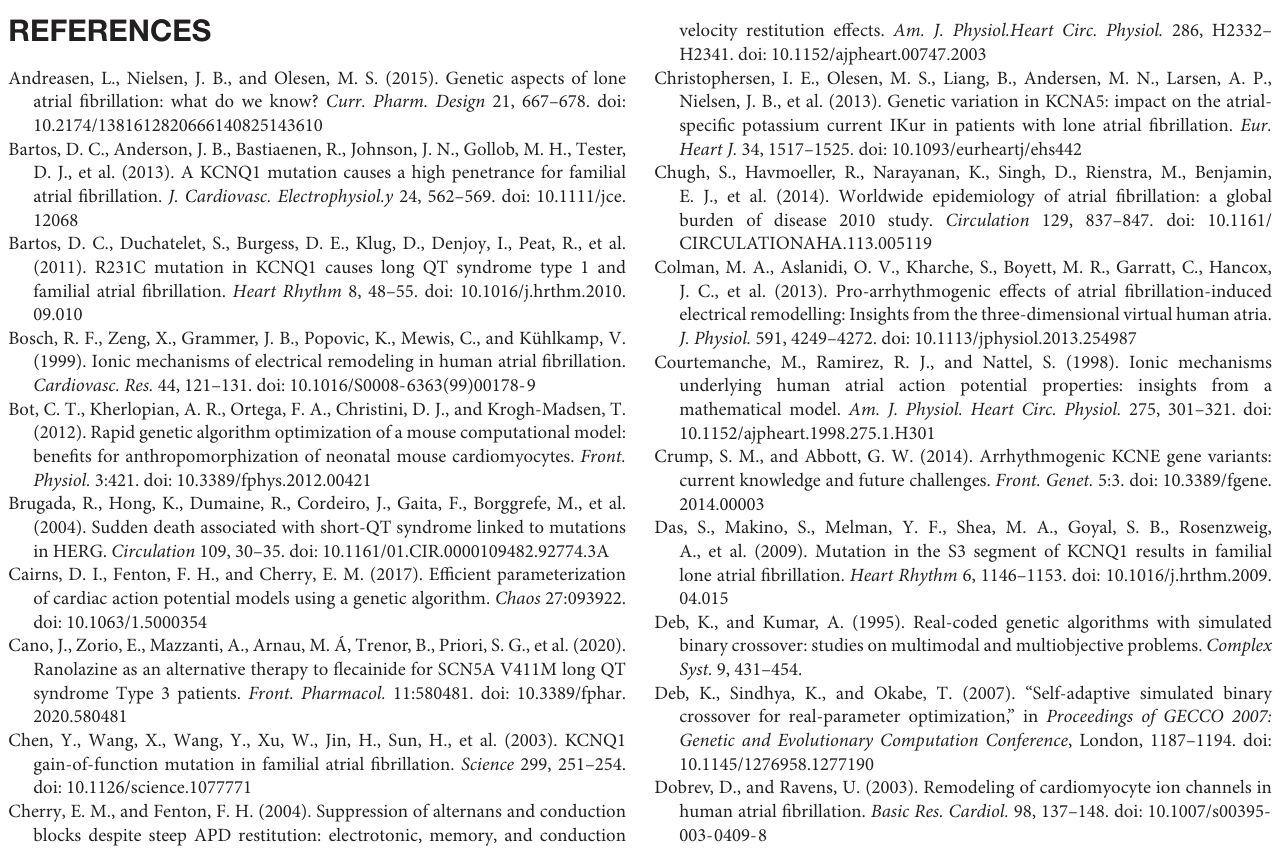
Supplementary Figure 1 | Sensitivity analysis for KCNH2 T436M and KCNH2 T895M I Kr current formulation. Supplementary Figure 2 | Sensitivity analysis for KCNE3-V17M mutated Kv11.1 channel complex. Supplementary Figure 3 | Sensitivity analysis for KCNE3-V17M mutated Kv4.3 channel